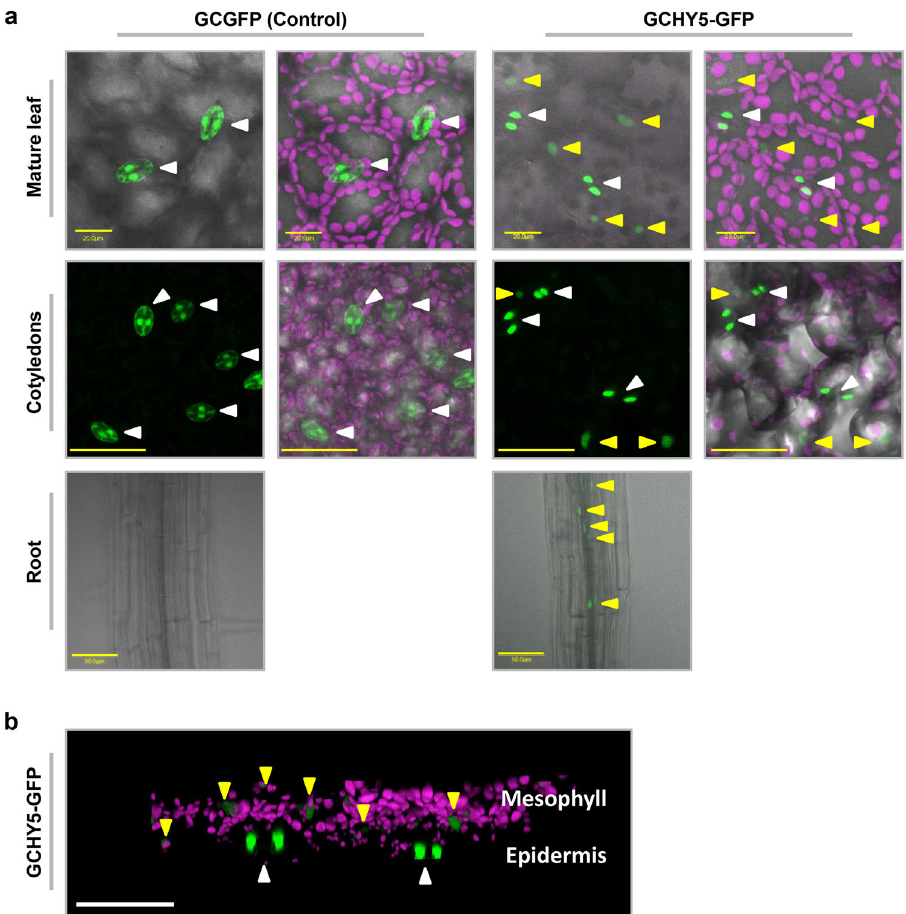
Fig. 7 HY5 produced within guard cells is translocated to mesophyll and root cells. a Distribution of GCGFP (control) or GCHY5-GFP in mature leaves, cotyledons and roots. All panels are merged images of white-light, chlorophyll-auto fl uorescence (stained magenta), and GFP- fl uorescence (stained green). Scale bars (yellow) are 20 µ m for mature leaves and 50 µ m for cotyledons and roots. b 3D simulation providing side views of GCHY5-GFP cotyledons, composed of epidermis and mesophyll cell layers. Image is a merge of chlorophyll-auto fl uorescence (stained magenta), and GFP- fl uorescence (stained green). Bar = 50 µ m. a , b White arrows indicate the location of GFP in guard cells and yellow arrows indicate the location of GFP in mesophyll cells of mature leaves and the cotyledons, and within the phloem of the